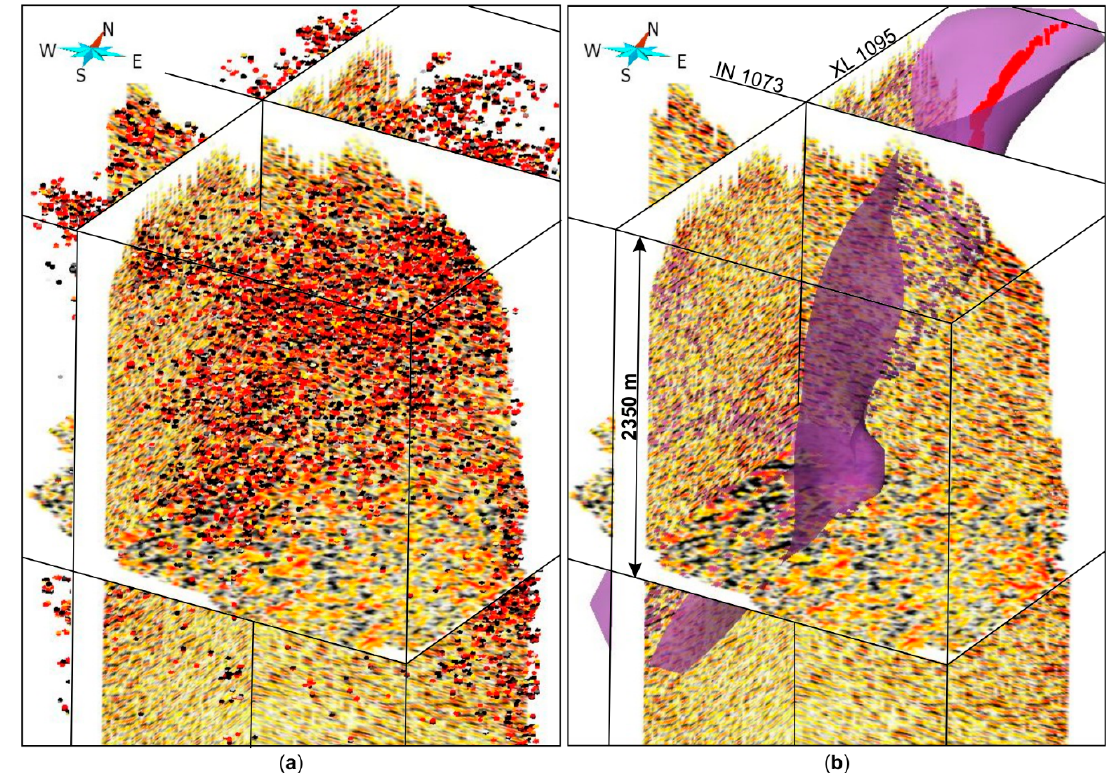
Figure 4. Fence diagram showing time imaging results extracted from the PoSTM volume along inline 1073, crossline 1095 and a depth slice at 2350 m depth: ( a ) geobodies extracted from the maximum amplitude; ( b ) Kylylahti mineralization (in red) and the interpreted base of the Kylylahti formation (in purple) based on seismic data. Figure shows spatial extent of the increased, piece-wise continuous reflectivity characterizing the Kylylahti formation.